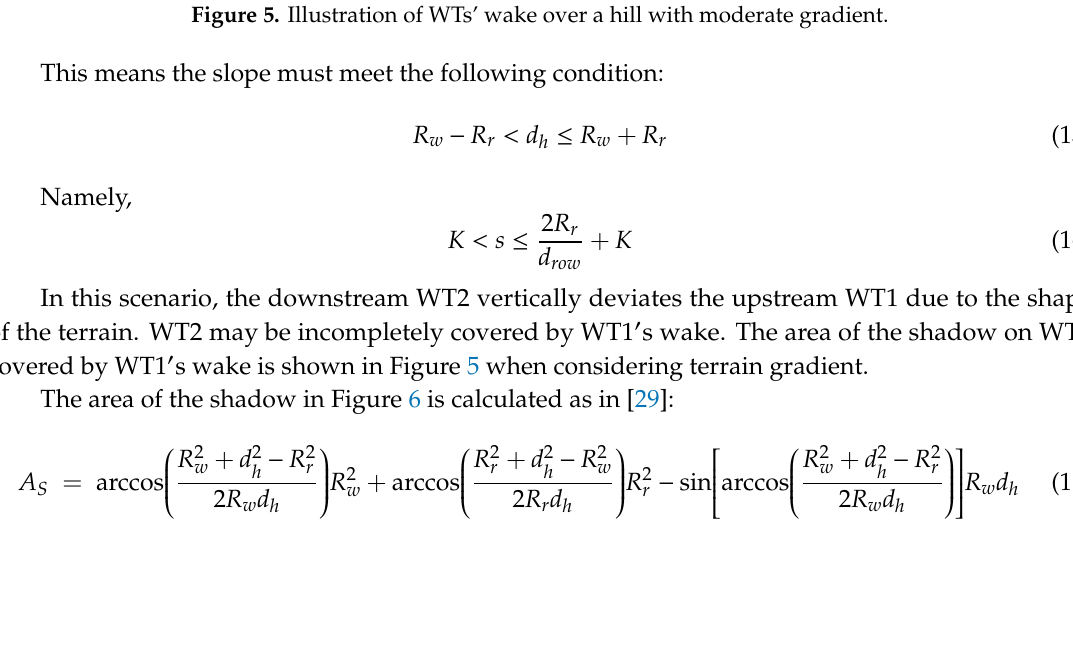
Figure 6. Two scenarios of wake overlap for a hilly WF. The area of the shadow in Figure 6 is calculated as in [29]: 2